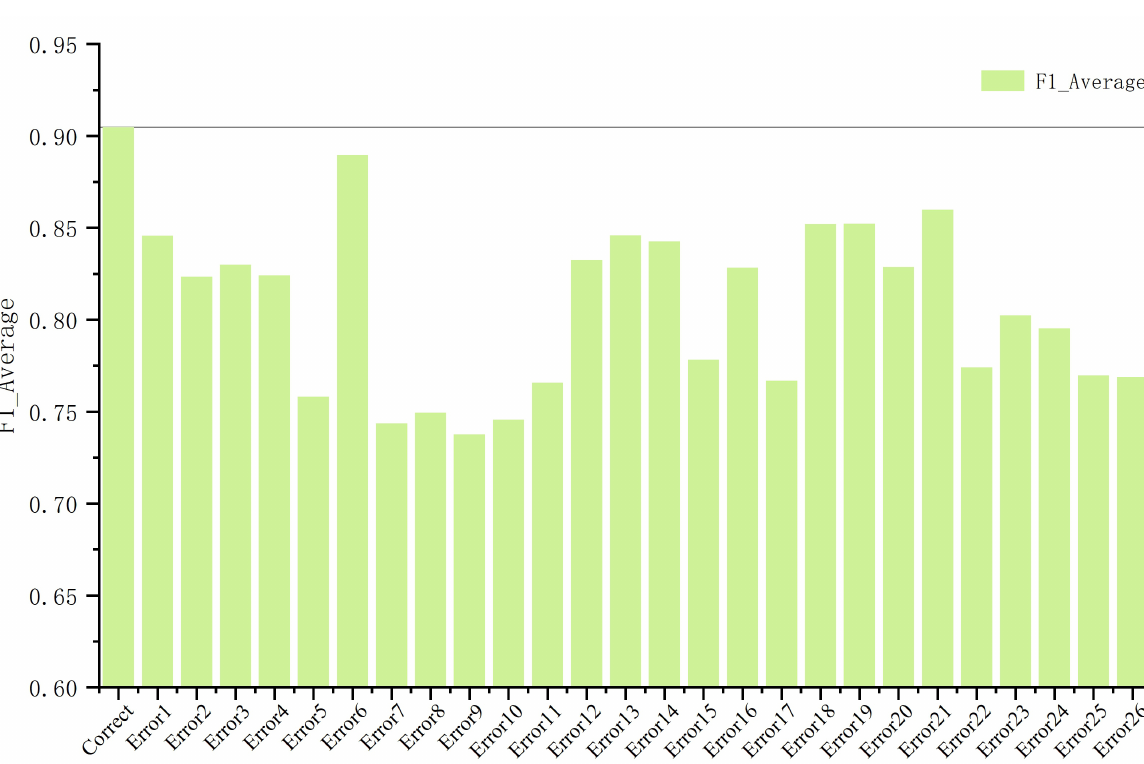
Figure A3. Average F1-score under different cost sensitive factors α